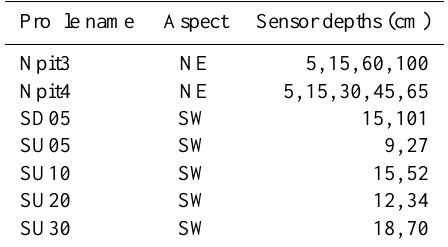
Table 3. Soil profile names, aspects, and sensor